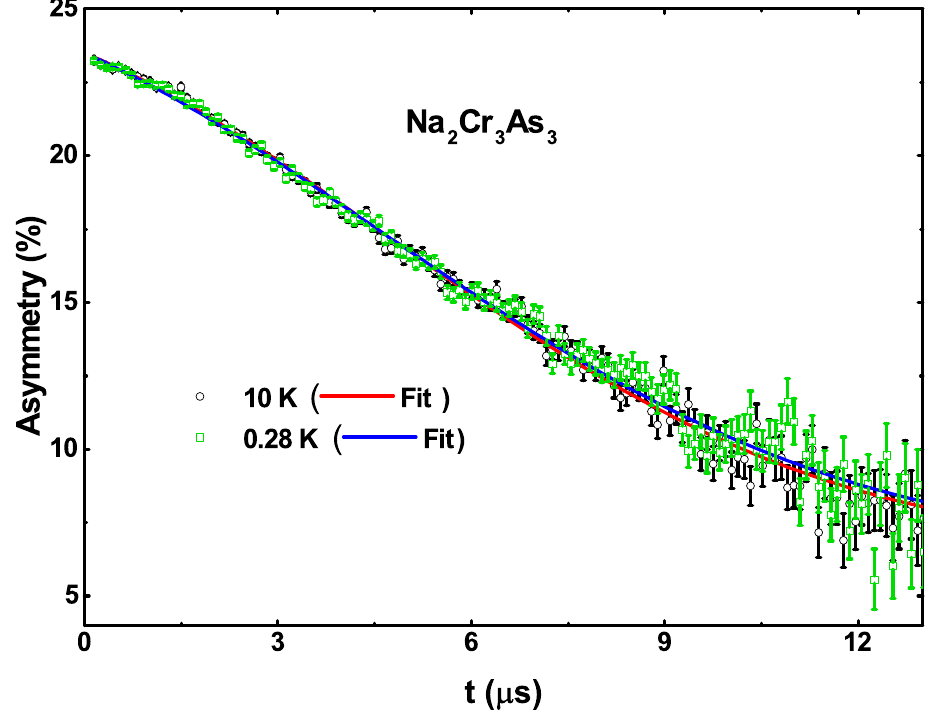
Figure 3. Zero-field µ SR time spectra for Na 2 Cr 3 As 3 collected at 0.28 K (green square) and 10 K (black circle) are shown together with lines that are least square fit to